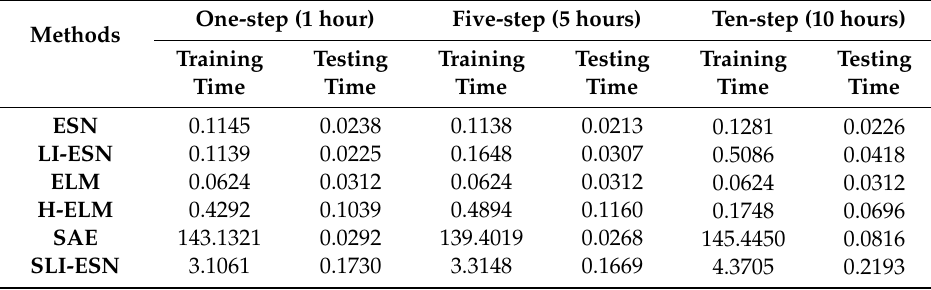
Table 5. Comparison of running time on six methods